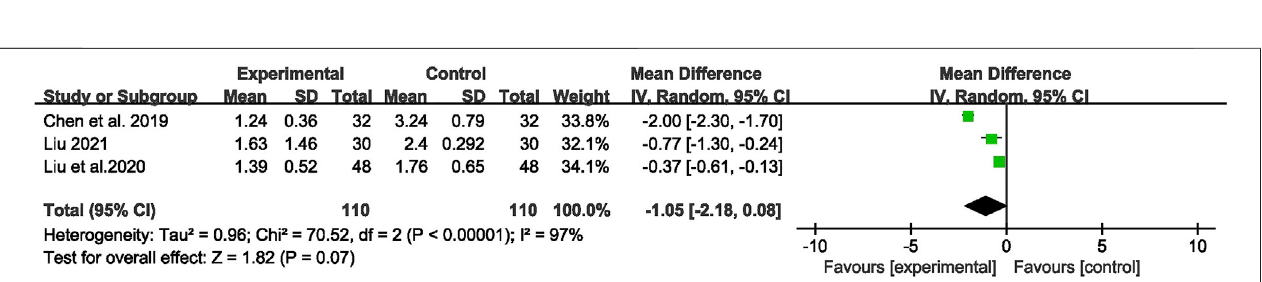
FIGURE 7 | Forest plot displaying the effects of CHM+AEDs vs. AEDs for seizure duration in patients with IE.